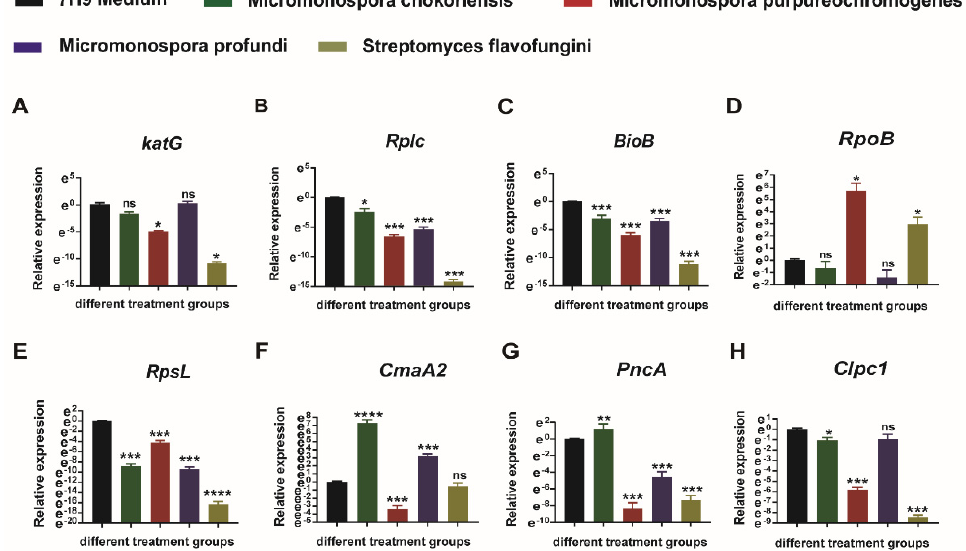
Figure 4. The expression level of M.tb essential genes after treatment with four selected fermentation products. Data presented as mean ± SEM. All experiments were performed in triplicate. The values of *, p < 0.05; **, p < 0.01; ***, p < 0.001; and ****, p < 0.0001 were considered statistically significant differences.